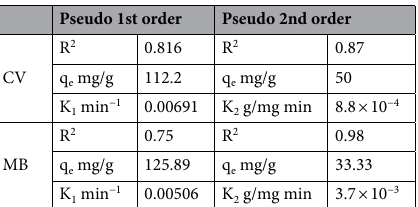
Table 3. Factors of pseudo 1st and 2nd order paradigms for MB&CV removal using MMT-mAmCs adsorbent.